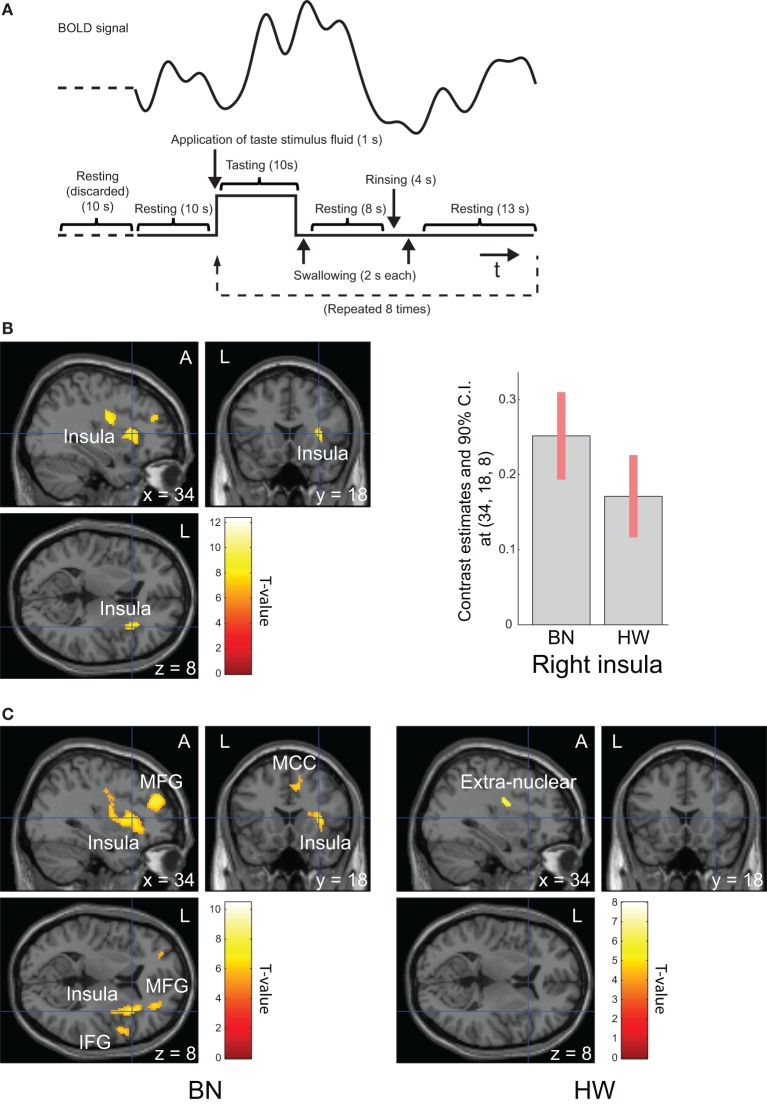
Task design and brain regions activated during tasting monosodium glutamate (MSG) solution. Functional magnetic resonance imaging task design, timeline of events, a representative timecourse of observed blood-oxygen-level dependent (BOLD) responses (A). Brain regions activated during tasting the MSG solution for all participants (B, left) and patients with BN and HW (C). BOLD signal responses to MSG stimuli [(B), right]. Statistical maps were thresholded at P < 0.001 with familywise error (FWE) correction at peak level (B) or P < 0.05 with FWE correction at peak level (C). Then, both were thresholded at q < 0.05 with false discovery rate correction at cluster level. During tasting solution, BOLD signal response was shown in the right anterior insula for all participants. The bar graph [(B), right] represents relative activations in the right insula (x, y, z = 34, 18, 8) in response to MSG stimuli between the two groups. The error bar represents 90% of CI. A, anterior; BN, patients with bulimia nervosa; CI, confidence interval; HW, healthy women participants; L, left.